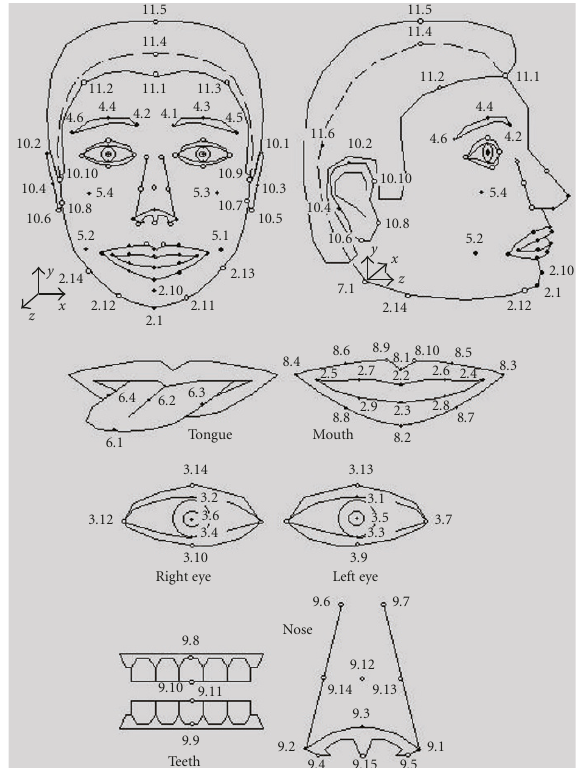
Figure 2: MPEG-4 facial definition parameters.